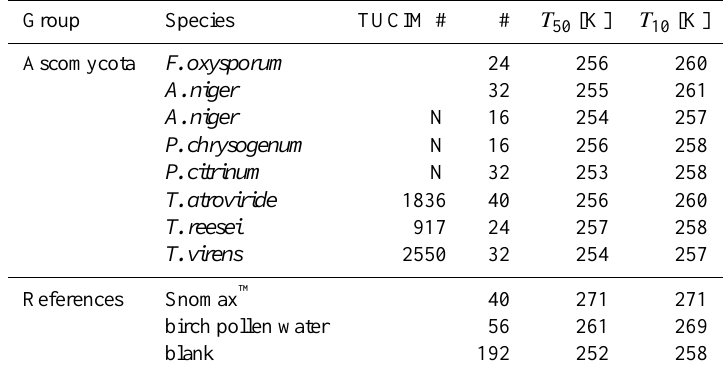
Table 4. A list of T 50 values for different ice nuclei in the droplet array mode. Species labeled with “N” in the TUCIM column are the naturally grown food mold samples. # is the total number of counted